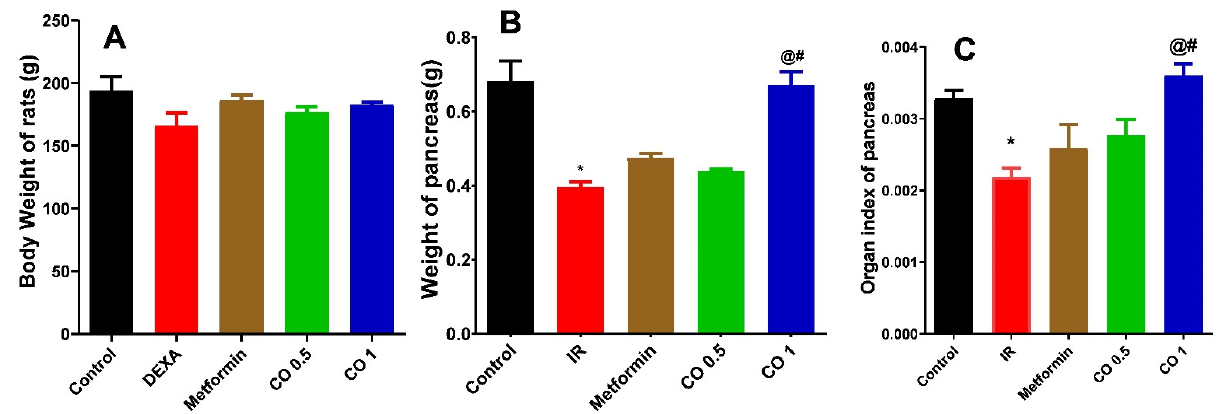
Figure 1. Effect of coriander oil (CO, 0.5 and 1 mL/kg, PO) and metformin (50 mg/kg/day, PO) on body weight ( A ), weight of pancreas ( B ), organ index of pancreas ( C ) in dexamethasone-induced insulin resistance in rats (IR). Results were analyzed by one-way ANOVA followed by the Post-hoc Tukey test. Results are shown in mean ± SEM ( n = 6). * , @, # p < 0.05 compared to normal, IR, and metformin groups, respectively.